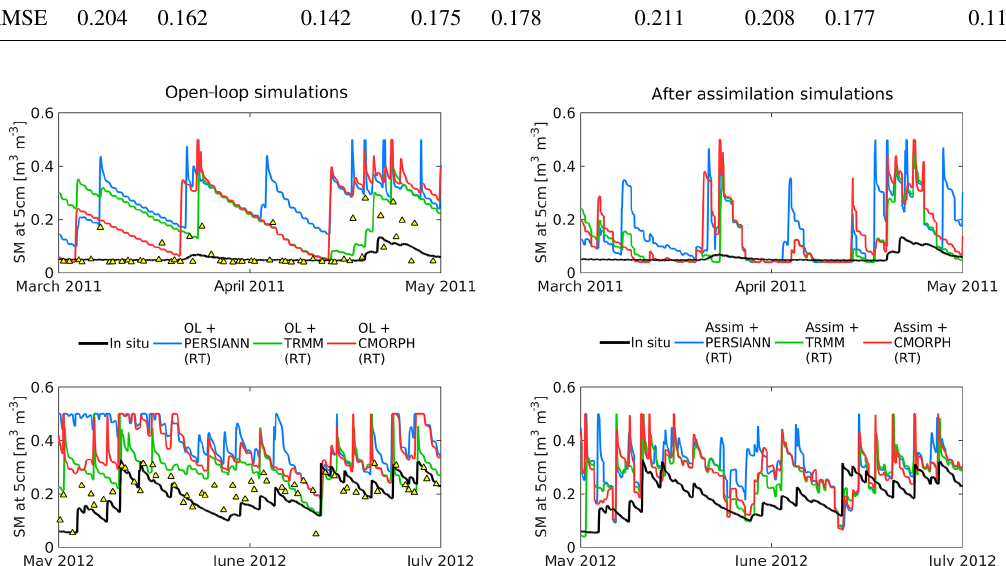
Figure 6. Comparison between the simulations of soil moisture at 5cm depth at the Bira station at two different time periods: dry season in 2011 (upper panel), and the beginning of the raining season in 2012 (lower panel). The open-loop simulations are represented on the left whereas the simulated soil moisture after assimilation are on the right. The different rainfall products are indicated with various colors. Assimilated SMOS observations are indicated by yellow triangles on the left